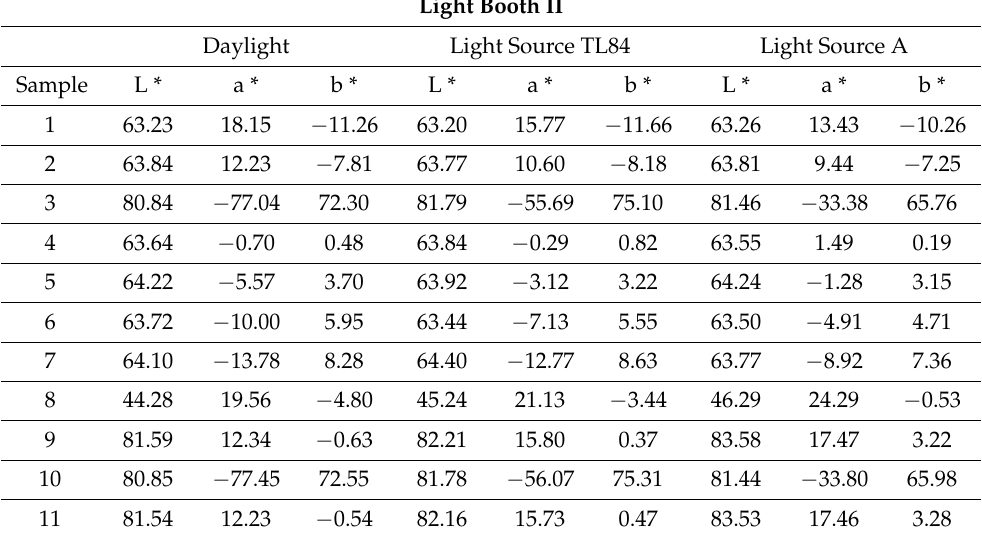
Figure 7. Average inter-observer variability of all metameric pairs under each light source with ( a ) standard deviation (SD) bars; ( b ) standard error of the mean (SEM). In the figure, BLED65, BLED40, and BLED27 represent the light sources with nominal CCT 6500 K, 4000 K, and 2700 K, respectively for light booth I; and Daylight (Simulator D65), TL84 (Tri-band fluorescent tube), and A (Tungsten lamp) represent the light sources with nominal CCT 6500 K, 4000 K, and 2700 K respectively, for light booth II.